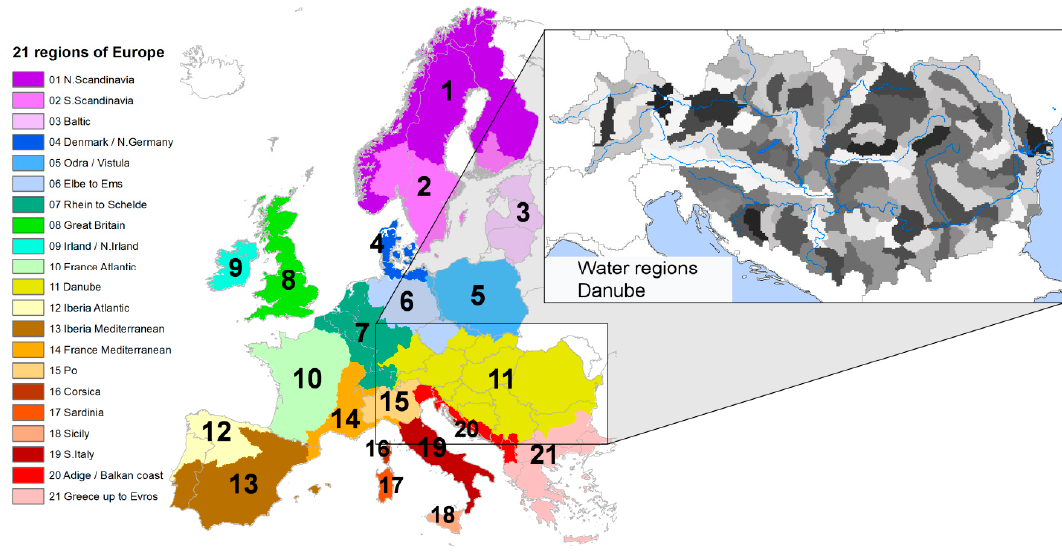
Figure 1. The 21 regions of Europe, as defined by river basins, climate and socio-economics. Right insert: the smaller “water regions” for the Danube river basin.